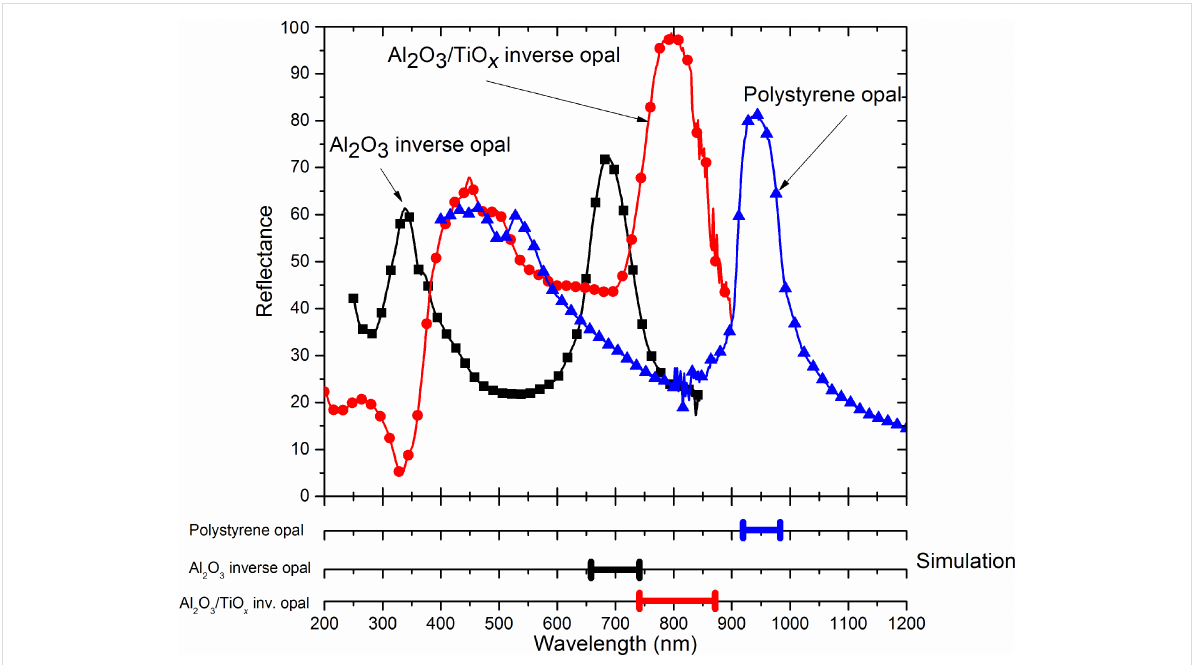
Figure 5: Reflectance measurements showing that the high reflection peaks closely match with the expected peaks calculated by simulation (in the lower part of the